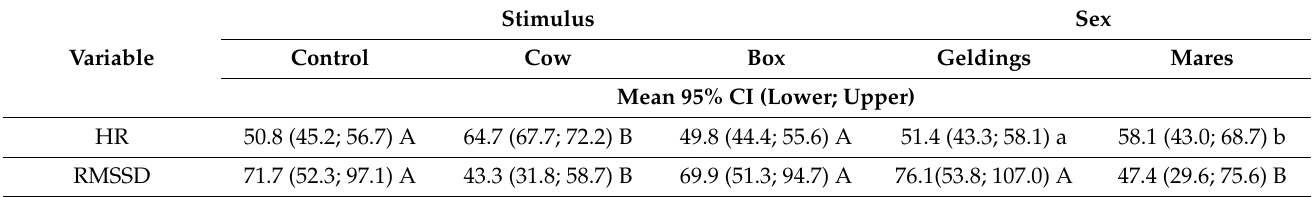
Table 5. The effect of stimulus and sex on HR (bpm) and RMSSD (msec).